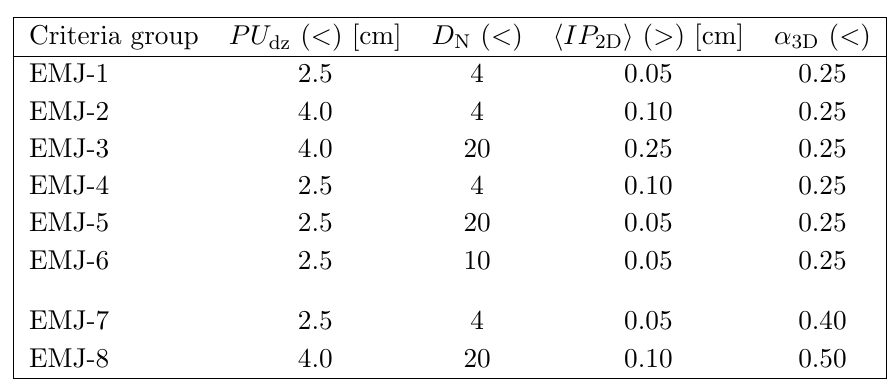
Table 2 . Groups of requirements (associated operator indicated in parentheses) on the variables used in the identi(cid:12)cation of emerging jets. The groups EMJ-1 to -6 are used for the selection sets that de(cid:12)ne the signal regions, while the groups EMJ-7 and -8 are used to de(cid:12)ne SM QCD-enhanced samples for the tests of the background estimation